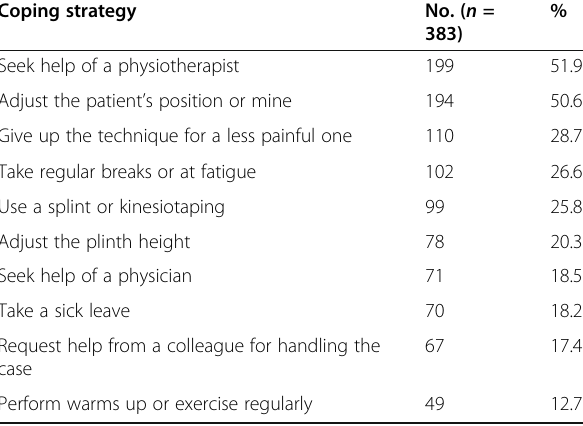
Table 4 Distribution of coping strategies used by Egyptian PTs Coping